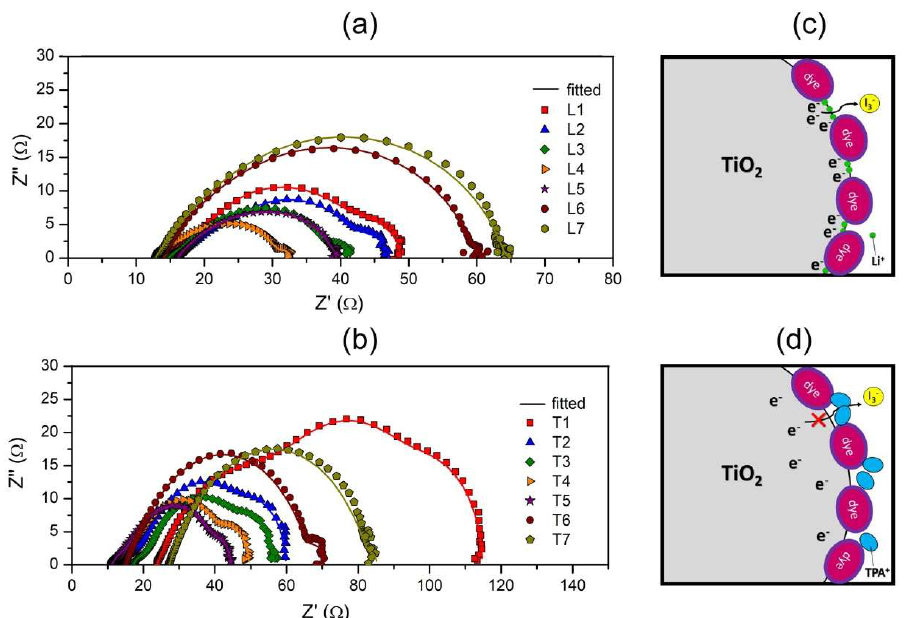
Figure 10. Nyquist plots of quasi-solid DSSC (QSDSSC) fabricated using ( a ) LiI and ( b ) TPAI gels and illustration of cation interaction with photoanode surface for ( c ) LiI and ( d ) TPAI gels.